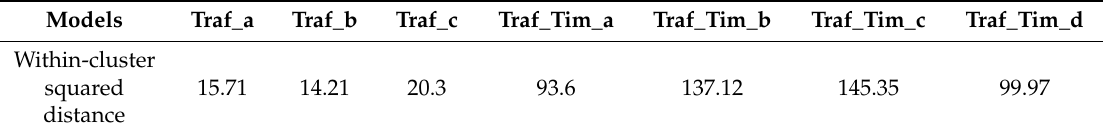
Figure 10. Real-time traffic ( a ) and a model based on traffic for prediction of PM 2.5 ( b ) for a larger (6.5 km × 5.5 km) area in central Quito. Table 2. Comparing the di ff erent models in terms of overall average within-cluster distance. The first three models are the ones obtained from tra ffi c (columns 2–4). The last four models are the ones built from tra ffi c and the time of day (columns